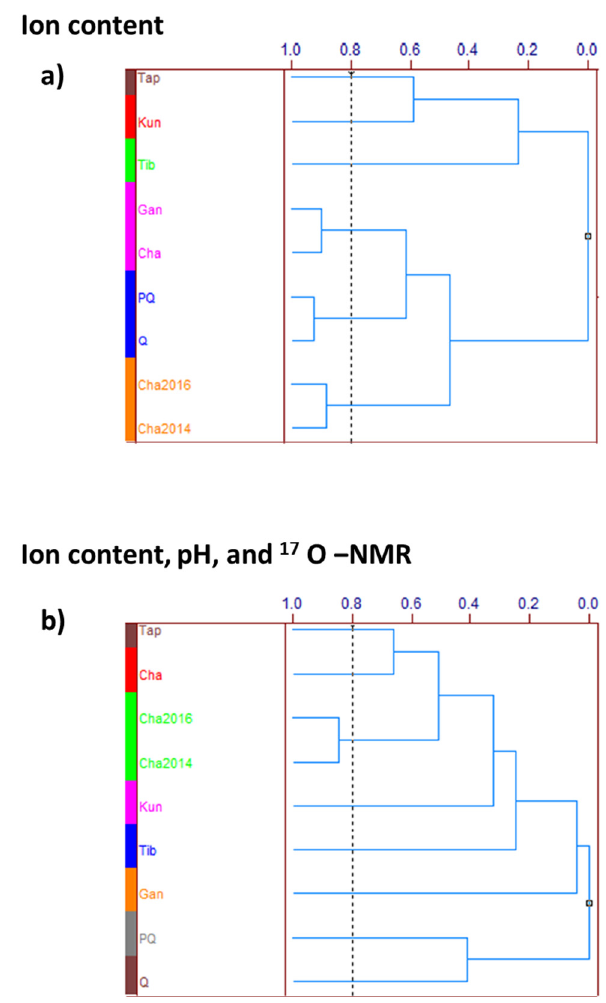
Figure 1. Dendrograms of HCA analysis performed using auto-scaled physico-chemical parameters (Table 1) (Panel a , b ). The nine different waters were classified into 6 groups based on ion type (panel a ) or 8 groups when pH and 17 O-NMR values were used in addition to the ion content (panel b ). The similarity between the thus found clusters was 0.8.